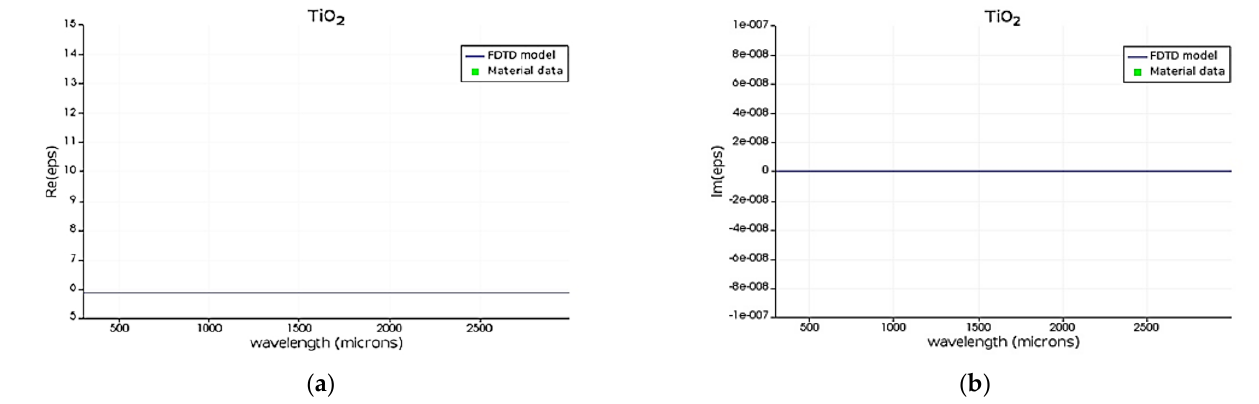
Figure A3. Dielectric constant of TiO 2 : ( a ) The real part of the dielectric constant; ( b ) The imaginary part of the dielectric constant.